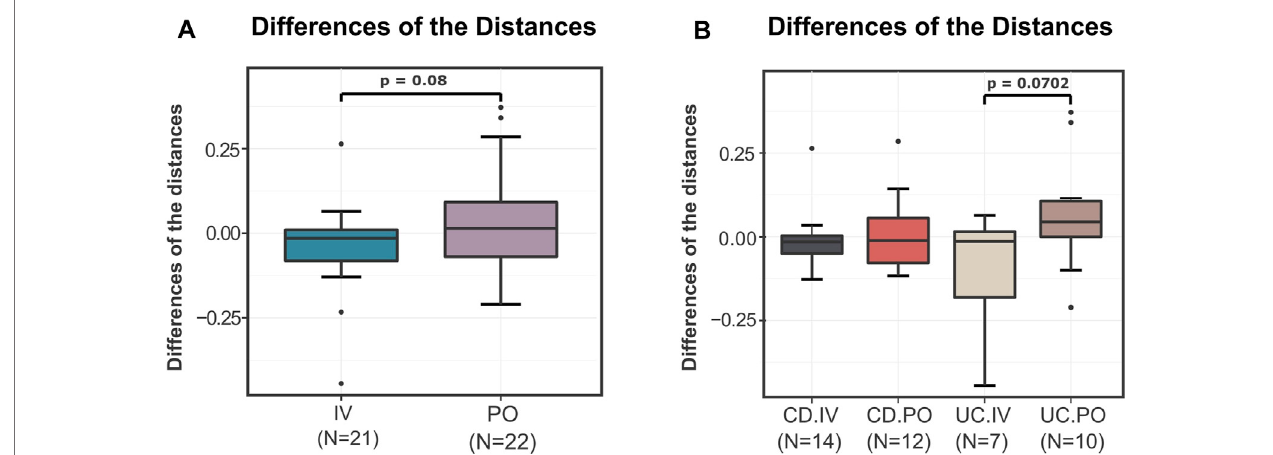
FIGURE5| Differences ofthe “ before – after ” distances ofthe test samplesfrom the closest referencemedoid oftheNIgroup. (A) Forthe samplesofthe IV and PO treatments, the differences of the distances from the closest reference medoid before and after the IRT were calculated. The boxplots illustrate the distribution of these differences. The IV treatment seems to have slightly but not signi fi cantly better results than the PO treatment ( p = 0.08). The average differences of the IV samples are negative(-0.0609),whiletheaveragedifferencesofthePOtreatmentarepositive(0.09715). (B) TheIBDsampleswerecomparedbasedonthetypeofthedisease and the treatment. In terms of distance to the reference samples, a differential treatment response is observed on UC patients ( p = 0.0702). CD patients do not seem to be affected by the mode of treatment, with both resulting in a slight convergence to the reference pro fi